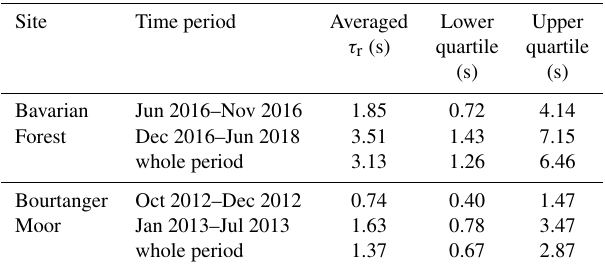
Table B2. Median τ r averaged over certain measurement periods at both